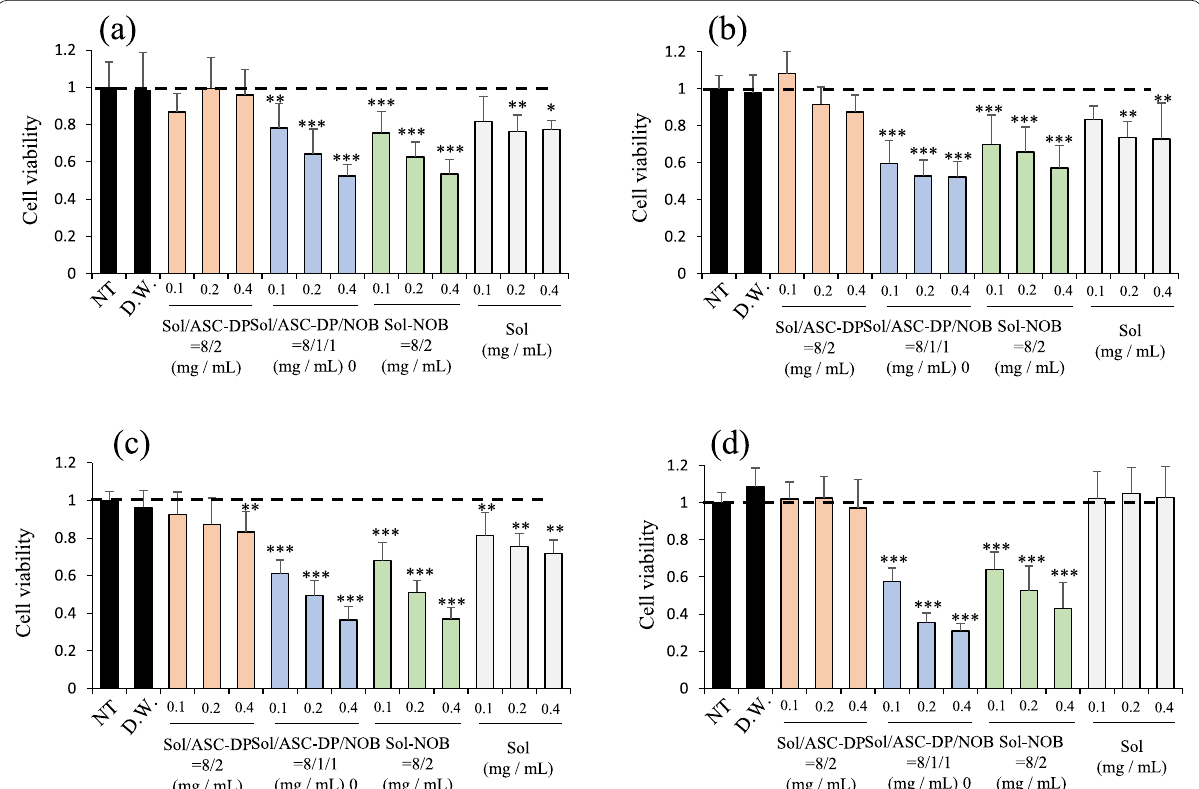
Fig. 12 Cell viability assays using Sol/ASC-DP/NOB systems. a A375, b B16, c 4T1, and d HaCaT. Results are expressed as means Dunnett’s test, and compared with those treated with distilled water, with significant differences at *** p < 0.001, ** p < 0.01, and * p <